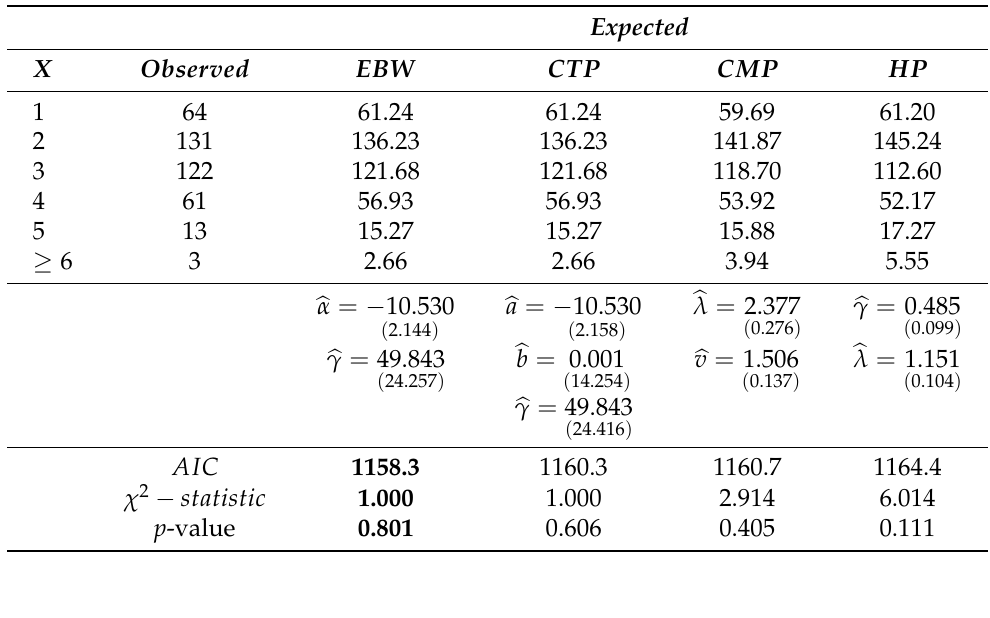
Table 7. Parameter estimates, standard errors (in parenthesis), observed and expected frequencies, AIC and χ 2 test for fits to data about the word length of a Turkish poem.